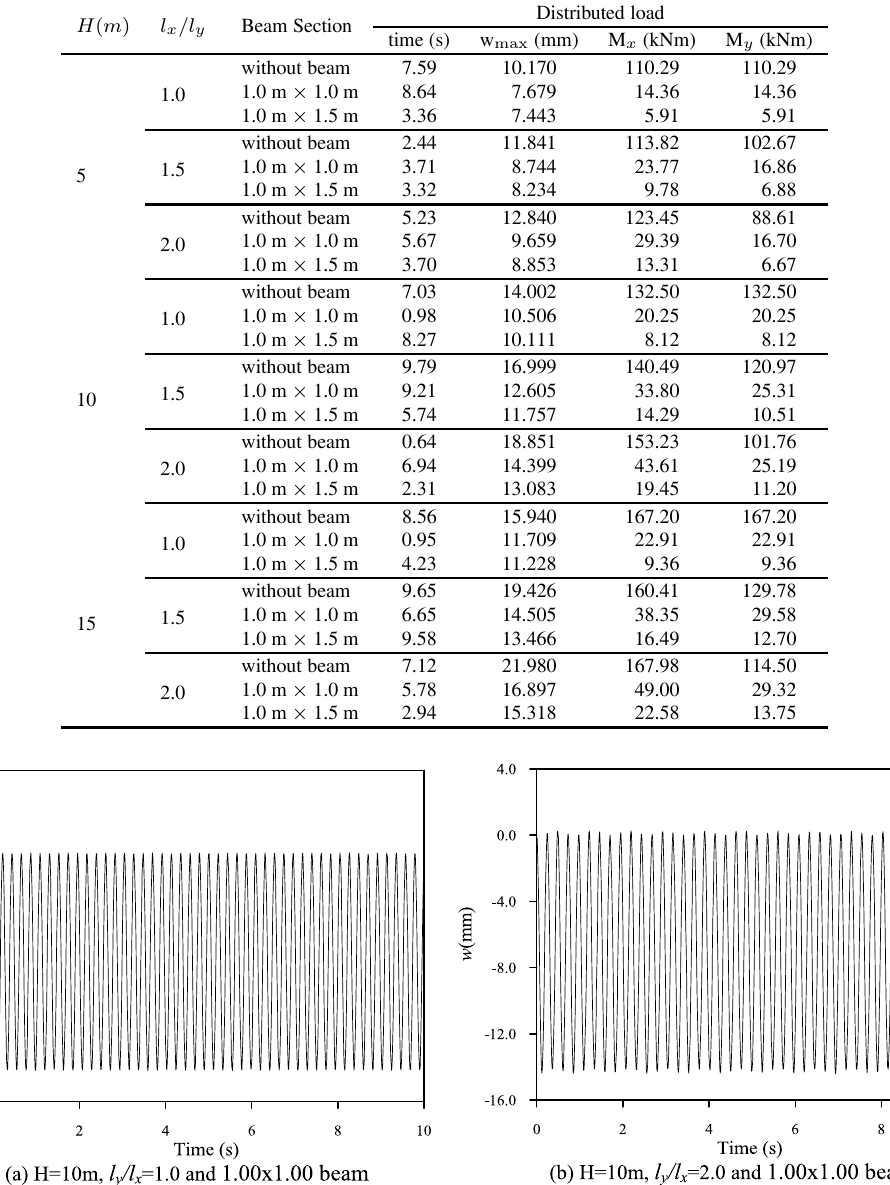
Table 3 Maximum displacements and bending moments of plates on elastic foundation